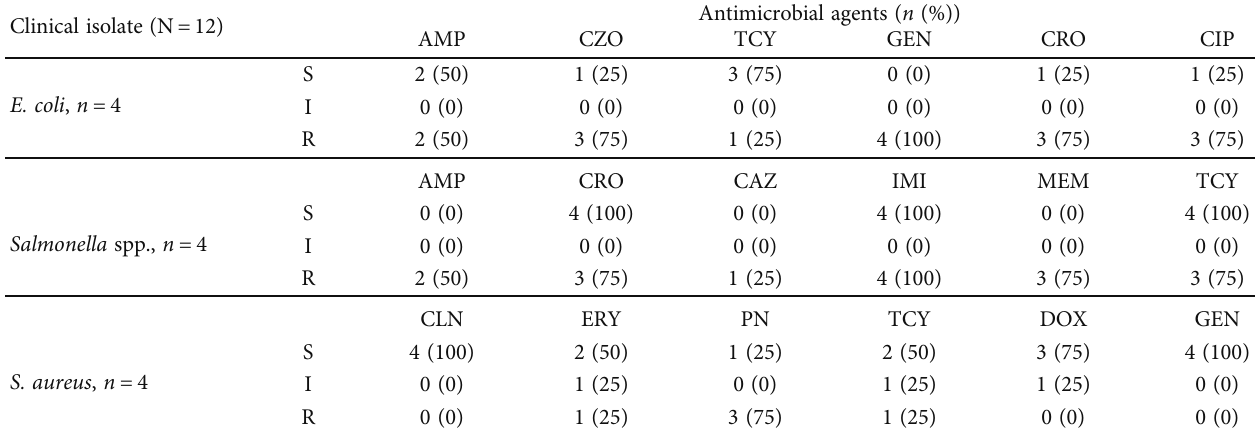
Table 8: Antimicrobial susceptibility pattern of indicator bacteria. Clinical isolate (N